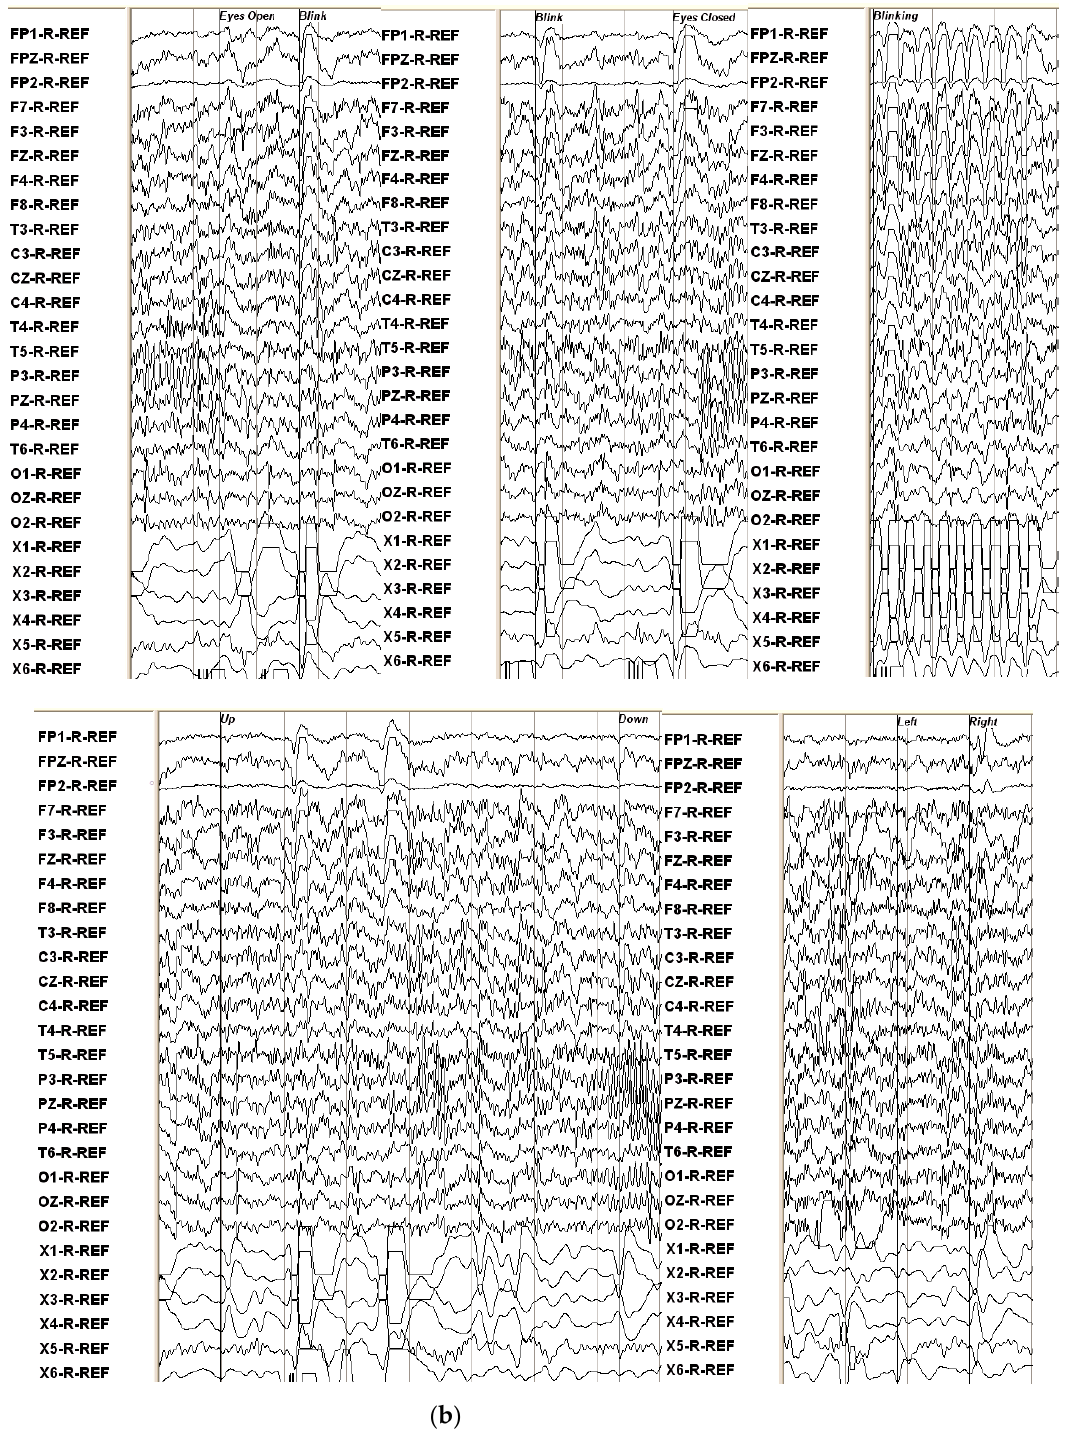
Figure 3. Examples of the electroencephalography (EEG) data with indications of the eight ocular artifacts: eyes open, eyes closed, blink, blinking, look up, look down, look left, and right, in the following: ( a ) NeuroSoft software (10 µV/mm, 7 mm/s); and ( b ) TWin software (15 µV/mm, 10 mm/s). R — a reference electrode placed at the right earlobe (A2). EOG, electrooculography.